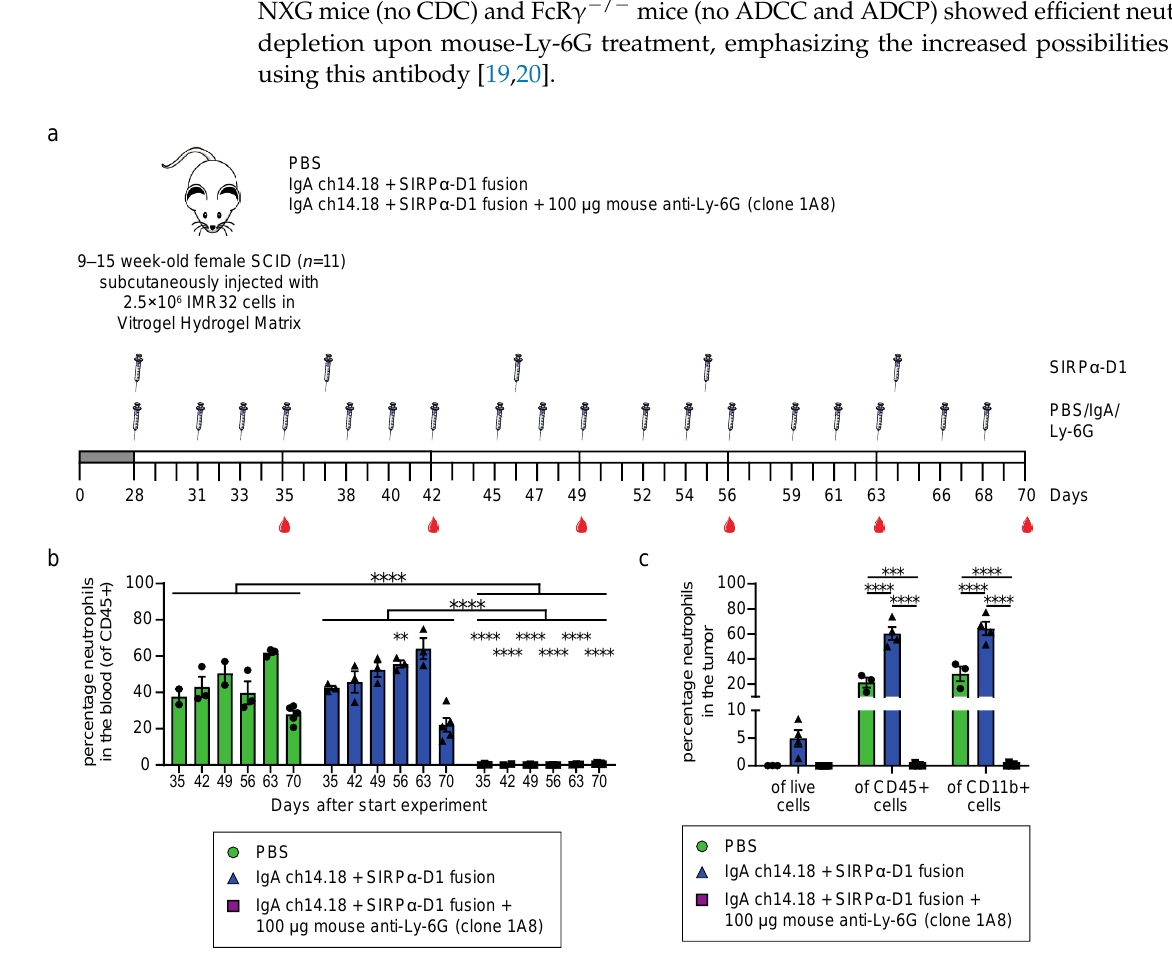
Figure 3. Mouse-Ly-6G efficiently depletes neutrophils in the blood and tumor of IMR32 tumor- bearing SCID mice ( a ) Experimental set-up; 2.5 × 10 6 IMR32 cells were s.c. injected in SCID mice in a 1:2 mix with Vitrogel Hydrogel Matrix. Tumors were established for 28 days, after which mice were randomized over the different treatment groups, and treatment was started. I.p. injections with PBS, IgA ch14.18, and mouse-Ly-6G were performed three times a week for six weeks. The SIRP α - D1 fusion protein was injected i.p. every nine days. Blood was drawn via cheek puncture once a week before injection with the antibodies; ( b ) Longitudinal analysis of the percentage of SSC high Ly- 6C low Ly-6G + CD11b + neutrophils in the peripheral blood ( n = 2 – 5 mice per group) of the CD45+ leu- kocyte population, showing complete neutrophil depletion upon treatment with 100 μ g mouse-Ly- 6G antibody. Of note; blood at day 70 was collected from the orbit and processed in a similar fashion as the tumor material, meaning cells were fixed at a later time point, possibly resulting in some neutrophil cell death; ( c ) Intratumoral analysis of the percentage of SSC high Ly-6C low Ly-6G + CD11b + neutrophils of the live (TO-PRO-3 negative) cells, CD45+ leukocytes, and CD11b+ myeloid popula- tions. Data showed increased tumor infiltration when the mice were treated with IgA ch14.18/SIRP α -D1 fusion, which was completely ablated when 100 μ g mouse Ly-6G was added. Data is presented as mean with SEM. Statistics: one-way ANOVA with Bonferroni correction. Re- peated measures one-way ANOVA with Bonferroni correction was used to compare groups in Fig- ure 3b, ** = p < 0.01, *** = p < 0.001, **** = p < 0.0001. 3.4. Neutrophil Depletion with Mouse-Ly-6G Is Not Solely Complement- or Fc Receptor-Mediated Neutrophil depletion with the rat-Ly-6G antibody is shown to be dependent on mon- onuclear phagocytosis but is facilitated by complement [30]. Since neutrophils were also efficiently depleted in NXG mice (Figure 2b), which, among other defects, did not show complement activity, the mouse-Ly-6G antibody should have been able to exert its